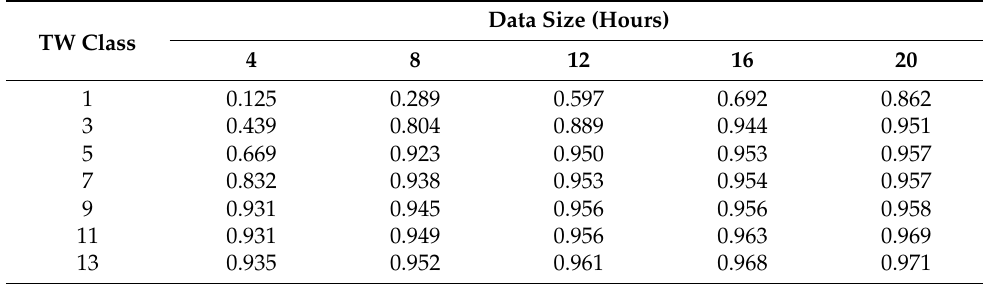
Table 3. Moving speed estimation accuracy of LSTM-C model according to data